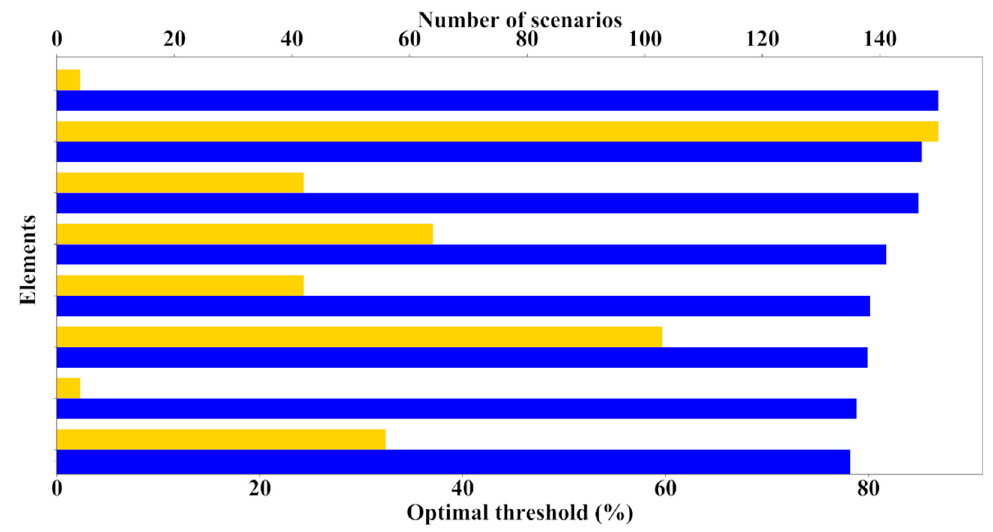
Figure 14. Optimal congestion threshold (in blue) and number of time scenarios (in orange) in a set of elements in the case study.